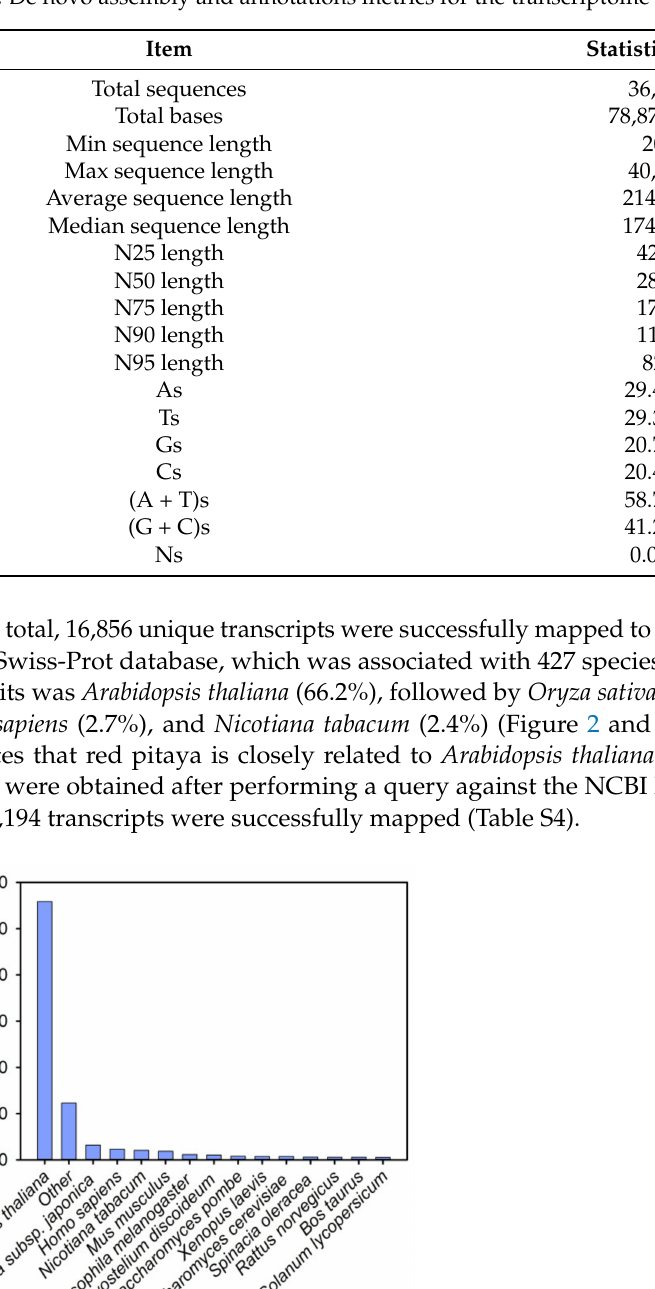
Table 1. De novo assembly and annotations metrics for the transcriptome of pitaya.